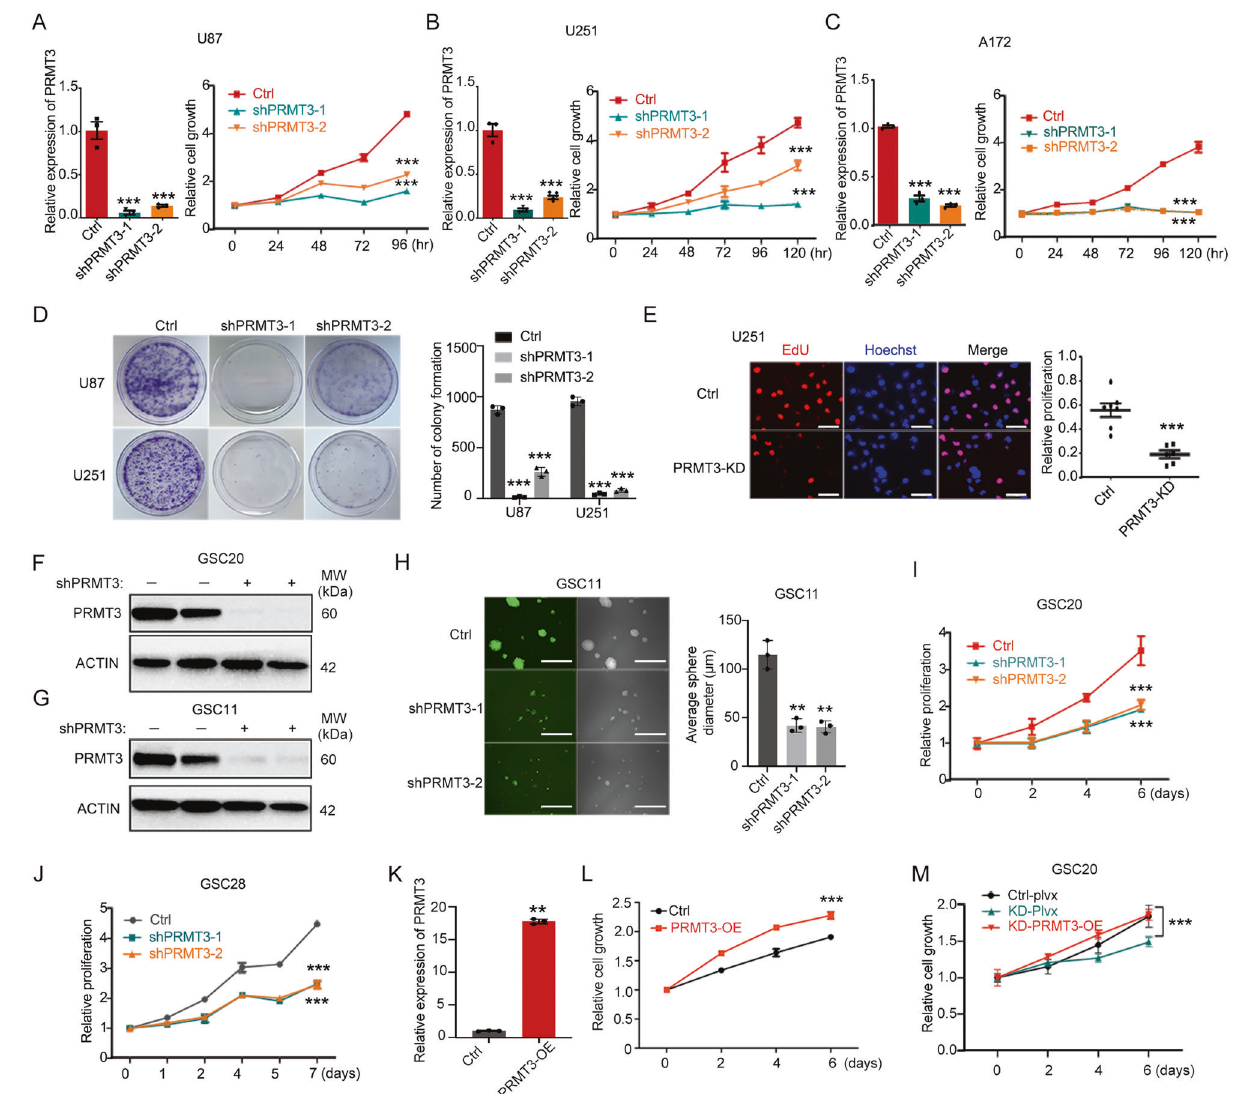
Fig. 2 PRMT3 is essential for GBM cell growth in cultures. A – C qRT-PCR validation of shPRMT3-mediated PRMT3 depletion in U87 ( A ), U251( B ) and A172 ( C ) cells (left) and the growth of U87 ( A ), U251 ( B ) and A172 (C) cells as tested by WST-1 assay (right). Growth curves are calculated at indicated days post-transduction of lenti-control or shPRMT3. Day 0 represents 2 days after PRMT3 knockdown. D Images of colonies of wild-type and PRMT3 -KD U87-MG and U251cells (left). Quanti fi cation (right) of relative clones. E EdU staining (left) and quanti fi cation (right) of wild-type and PRMT3 -KD U251 cells after 1 hour of EdU treatment. F , G Western blot validation of shPRMT3-mediated PRMT3 depletion in GSC20 ( F ) and GSC11 (G) cell cultures. ACTIN: loading control. H Representative images of spheres (left) and quanti fi cation (right) of sphere sizes of GSC11 Ctrl and PRMT3 KD cells. I - J Cell growth curves of GSC20 ( I ) and GSC28 ( J ) cells treated with control shRNA- or shPRMT3 lenti-virus as determined by WST-1 assay. Day 0 represents the assay start from 2 days after transduction. K qRT-PCR validation